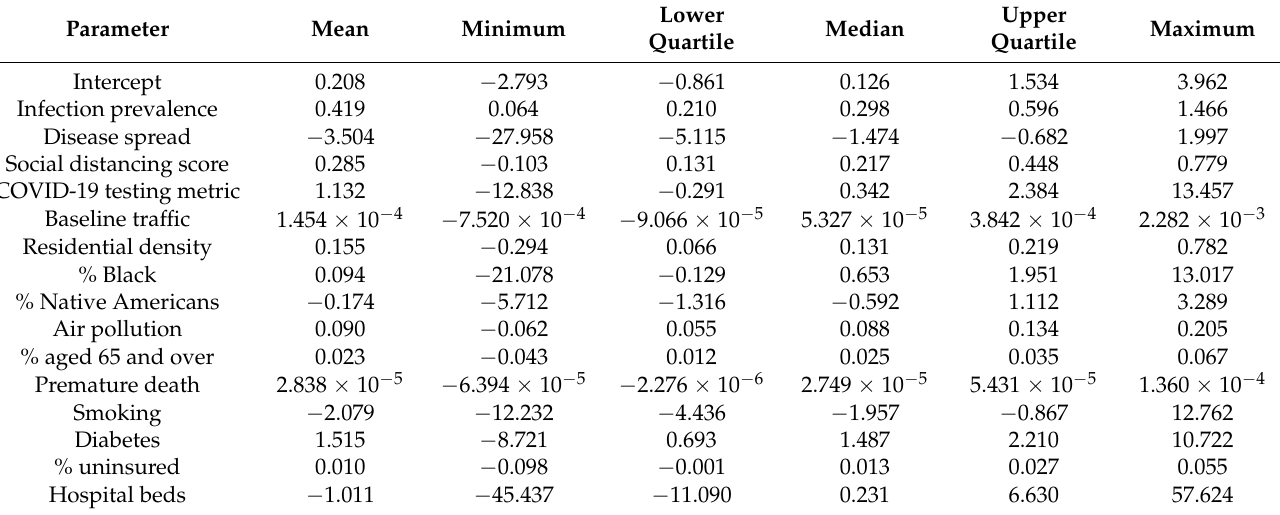
Table 4. Parameter estimates of the GTWR